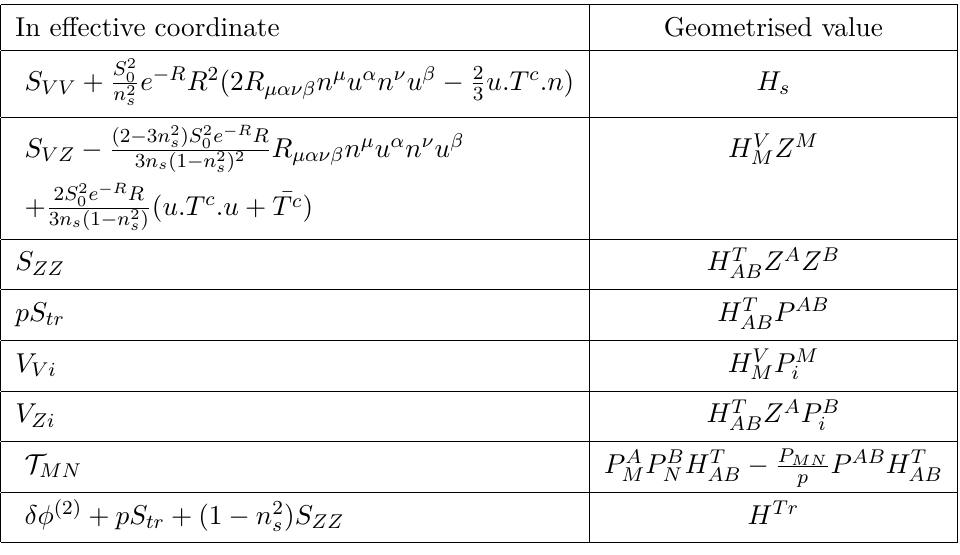
Table 2 . Geometrisation